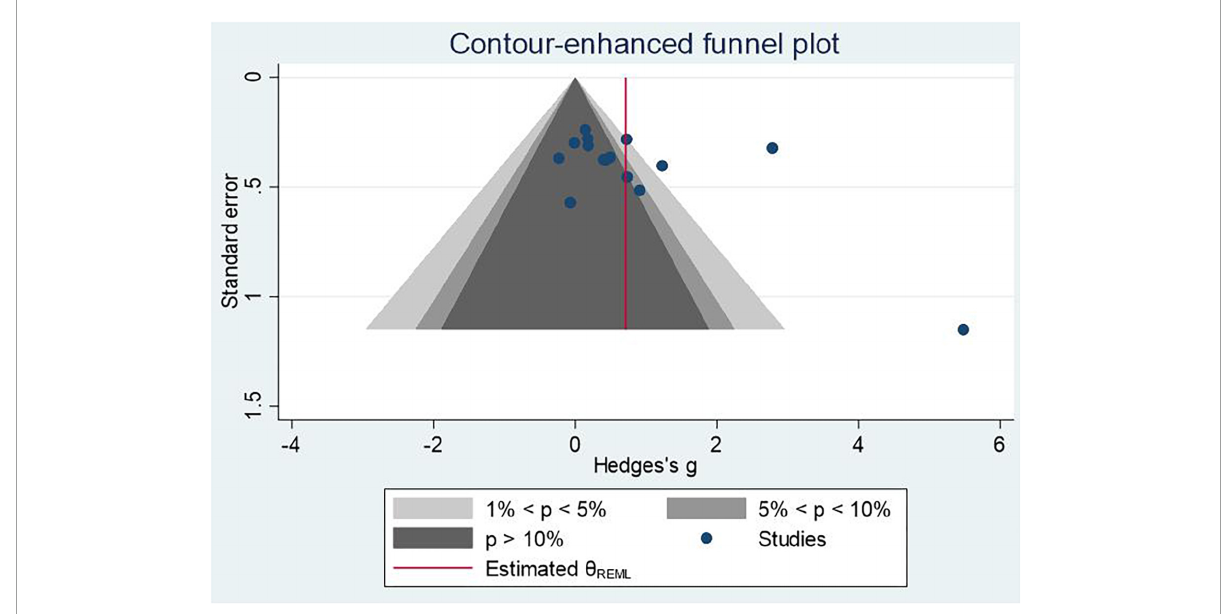
FIGURE13 Funnel plot for publication bias and result of clipping